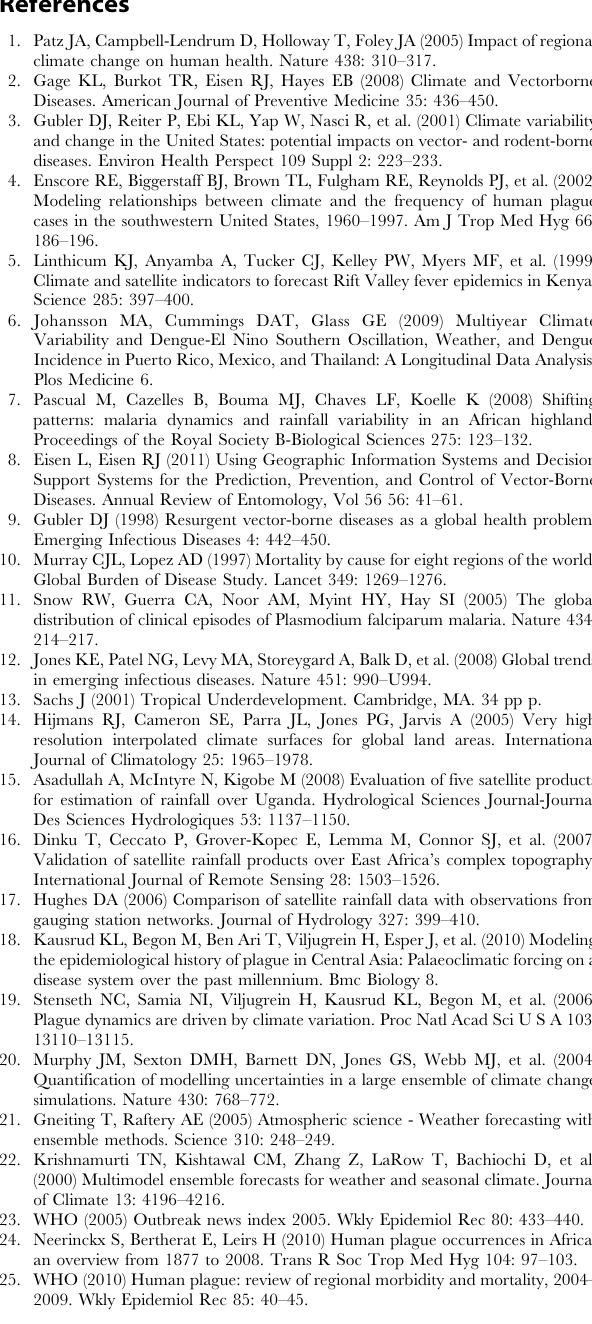
Table S1 Correlation matrix for the seven different rainfall datasets. Table S2 Correlation values for rainfall datasets at each of the 11 meteorological stations within a 500 km radius of our study region. Table S3 Mean model AICc, D AICc values and coefficient estimates and 95% confidence intervals for the consensus best two- variable models with square-root transformed number of suspect plague cases as the response